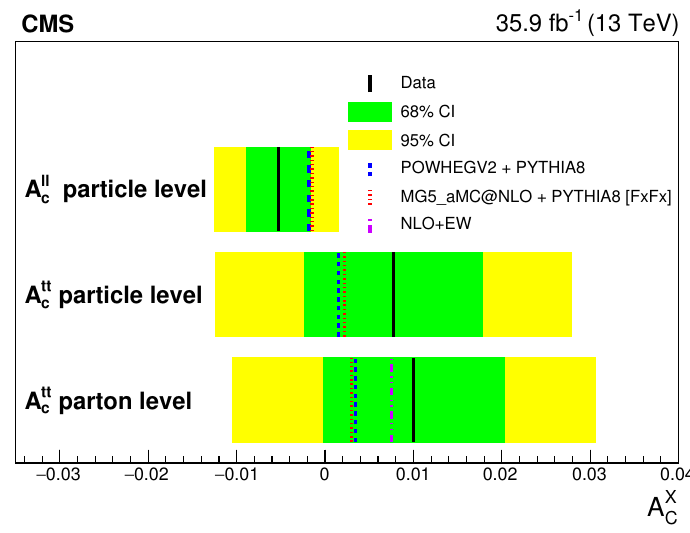
extraction (x = tt or ‘ (cid:22) ‘ ) from integrating the normalised parton- Figure 55 . The results of the A x c and particle-level di(cid:11)erential cross section measurements as a function of (cid:1) j y j (t ; t) and (cid:1) (cid:17) ( ‘; (cid:22) ‘ ) are shown. The central values for the data are indicated by the solid lines with the 68 and 95% CIs represented by the dark and light shaded bands, respectively. The three types of dashed lines indicate the SM predictions produced with the mg 5 a mc@nlo and powheg generators, both interfaced with pythia , and a calculation at NLO precision in QCD and including corrections arising from mixing between QCD and electroweak diagrams, and between QCD and QED diagrams